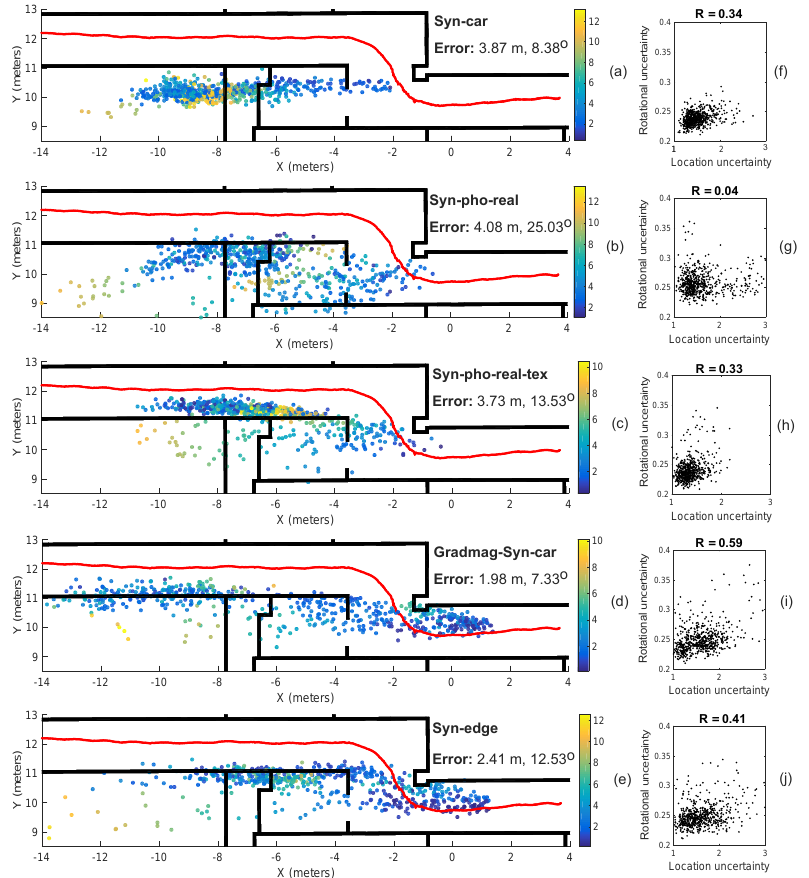
Figure 8. The results of the network (a) fine-tuned with Syn-car and tested on real images (b) fine-tuned with Syn-pho-real and tested on real images (c) fine-tuned with Syn-pho-real-tex and tested on real images (d) fine-tuned with Gradmag-Syn-car and tested on edge gradmag of real images (e) fine-tuned with Syn-edge and tested on edge gradmag of real images. Uncertainty plots for (f) Syn-car (g) Syn-pho-real (h) Syn-pho-real-tex (i) Gradmag-Syn-car and (j) Syn-edge